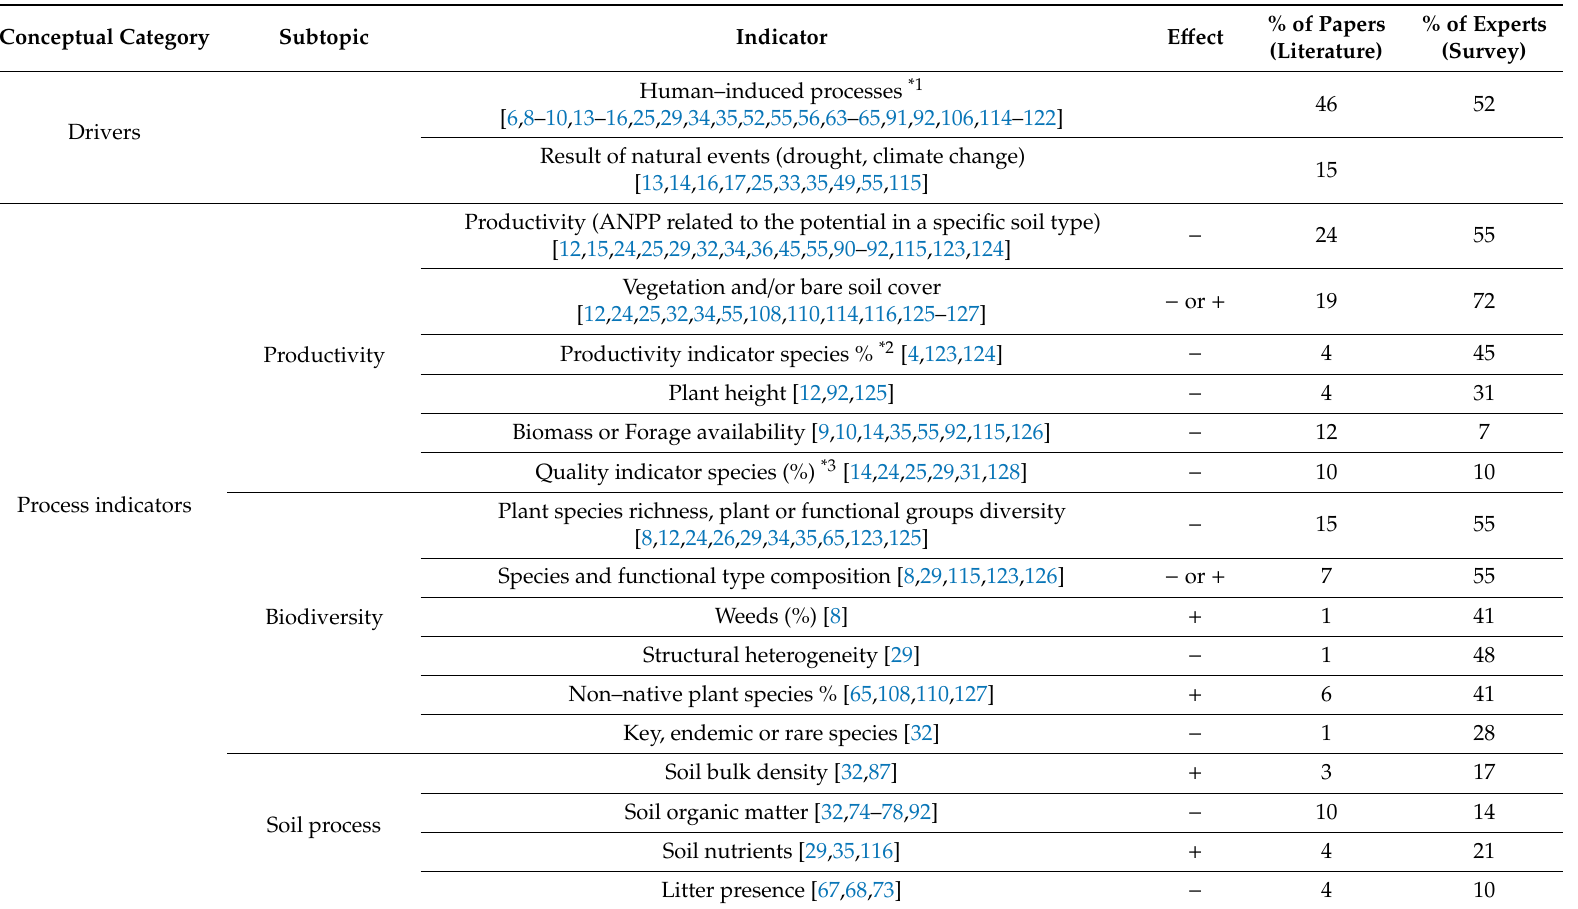
Table 1. Frequency (%) of the most relevant indicator mentioned in the literature review (from a total of 67 analyzed papers) and expert survey (from 29 experts who answered the survey). Some papers or experts mention more than one indicator. The “ + ” and “ − ” signs indicate the e ff ect of the natural grassland’s degradation on that indicator: a decrease ( − ) or an increase ( + ). Indicators are grouped following the conceptual framework present in Figure 1. *1 (overgrazing, under-grazing, fragmentation); *2 (high forage value: quality and stability in time); *3 (related to livestock preference); *4 (mainly livestock production); *5 (water cycle, nutrient cycle, energy flow, species